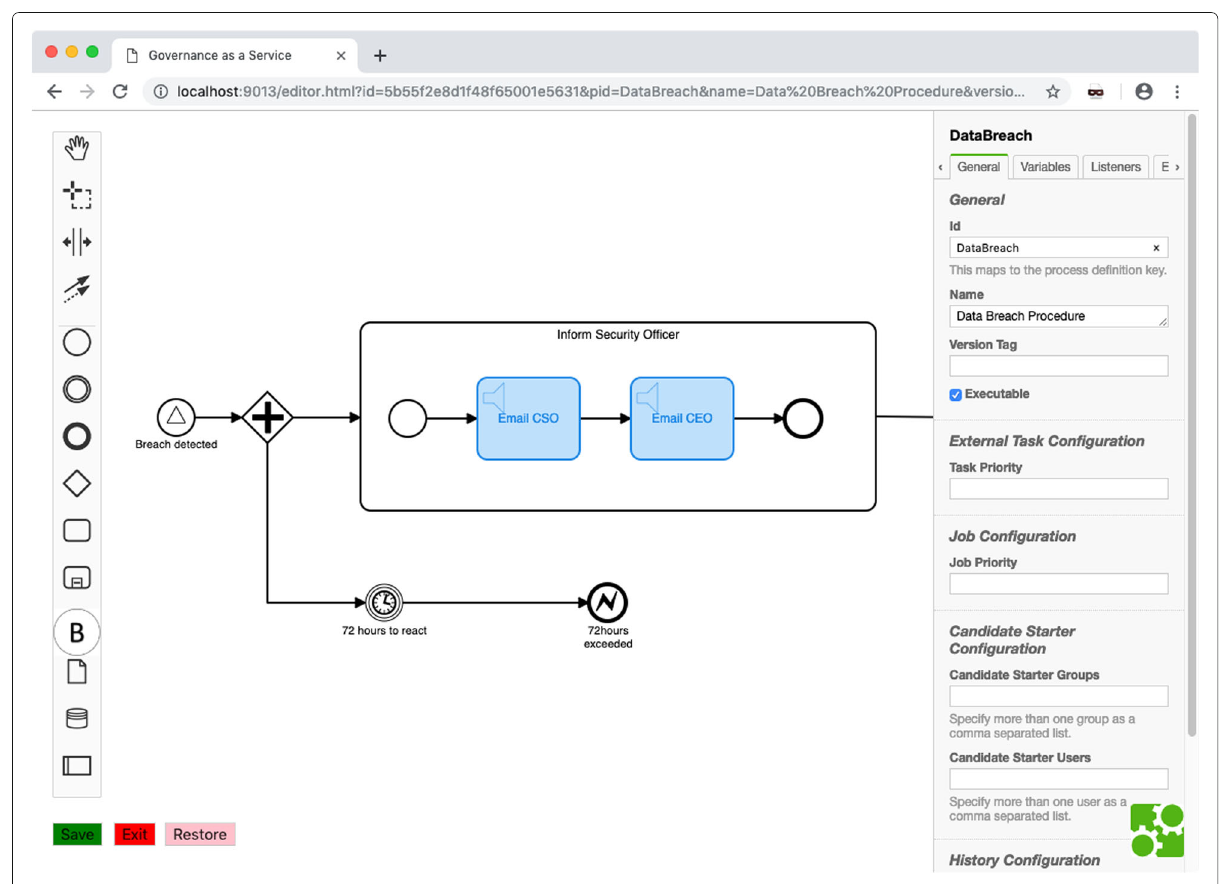
Fig. 15 Screenshot of process editor